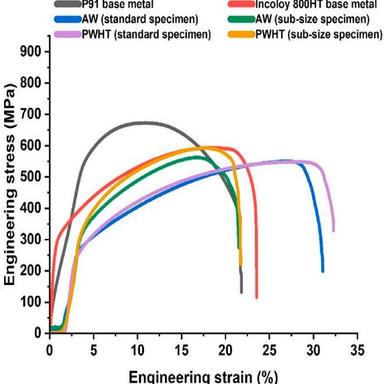
Plotted engineering stress-strain curves for base metals and tested tensile specimens.